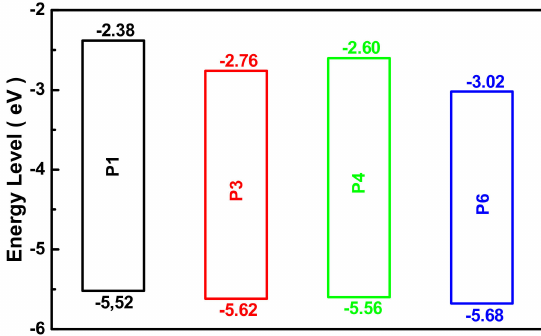
Figure 8. Cyclic voltammograms of